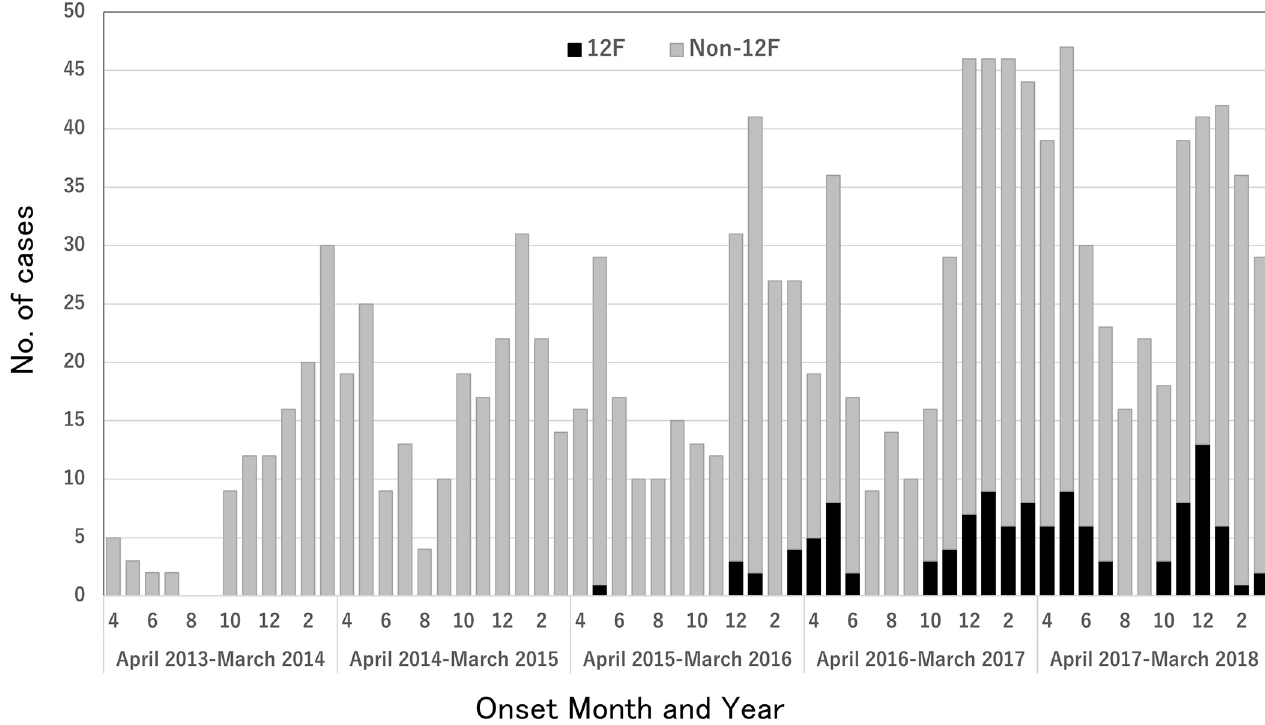
Fig 1. Epidemiological curve of invasive pneumococcal disease (IPD) among adults between April 2013 and March 2017 in 10 provinces, Japan. Closed bar denotes 12F serotype IPD, open bar denotes non-12F serotype IPD.